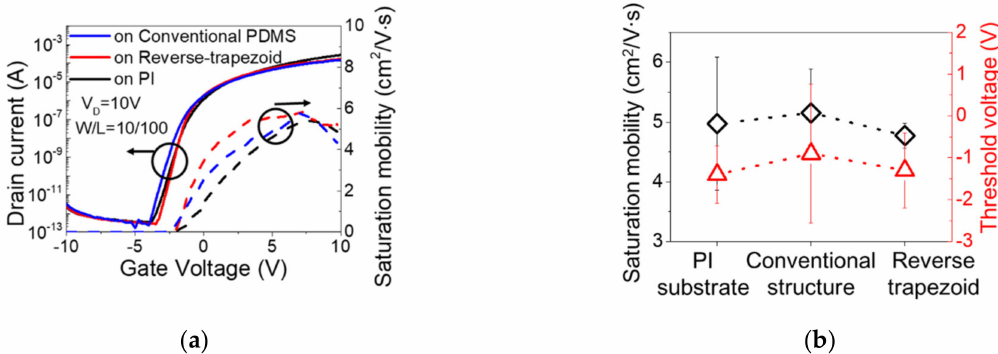
Figure 3. Effects of substrate types on the electrical properties of a -IGZO TFTs. ( a ) Transfer characteristics, ( b ) the saturation mobility and threshold voltage of a -IGZO TFTs on various substrates.